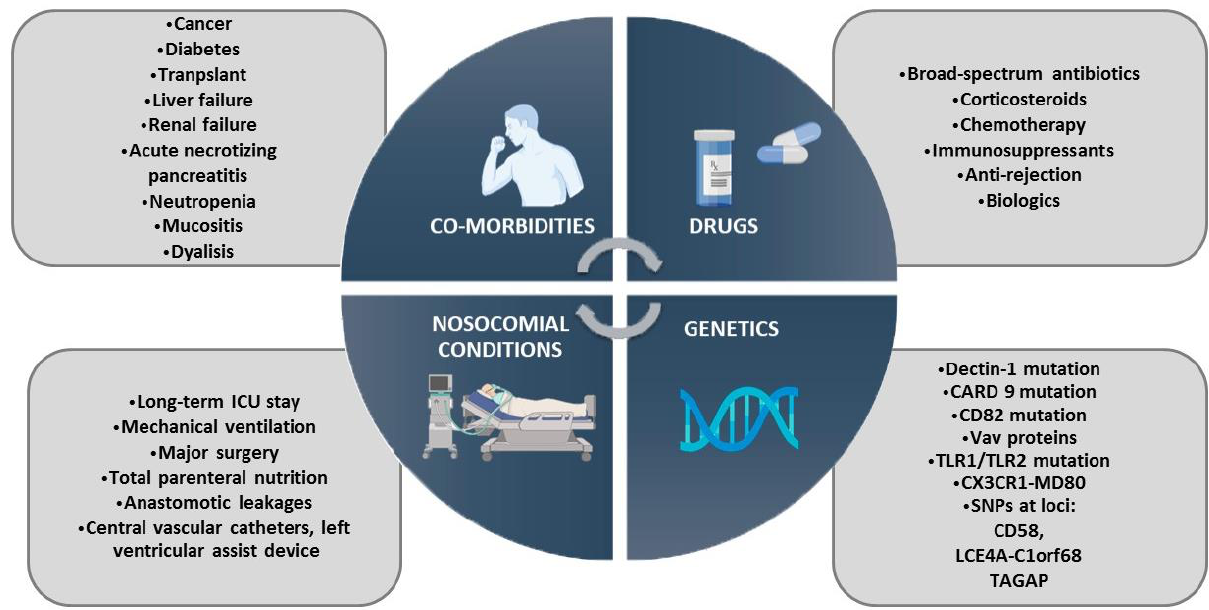
Figure 2. Risk Factors Predisposing to Invasive Candidiasis, categorized into four Groups: Co-Mor- Morbidities, Nosocomial Conditions, Drugs and Human Genetic bidities, Nosocomial Conditions, Drugs and Human Genetic Factors.